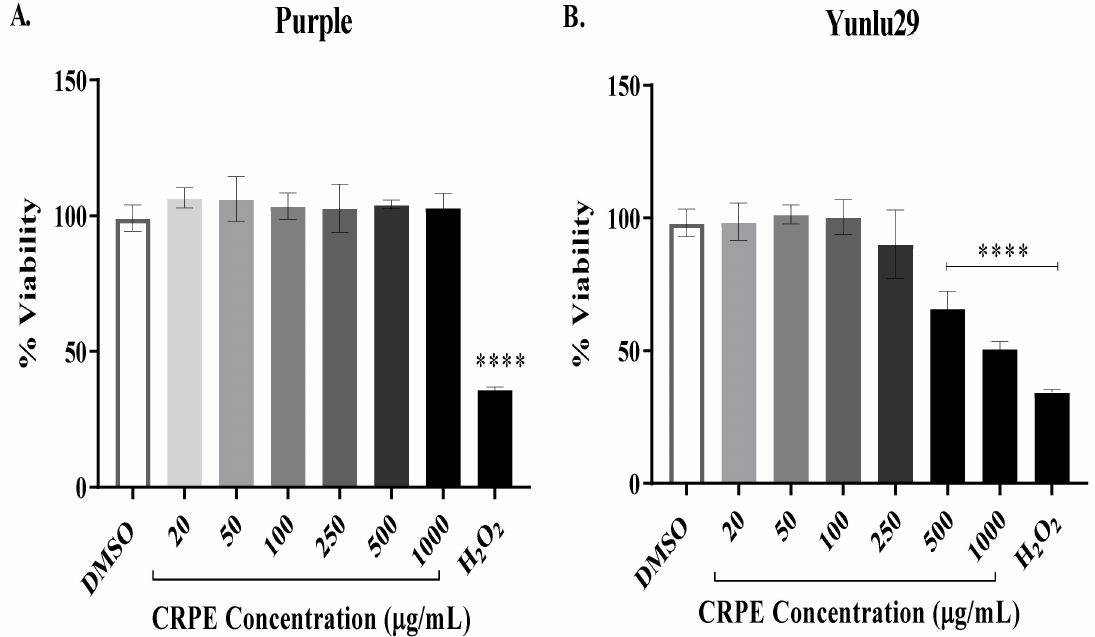
Figure 1. Cytotoxicity of coloured rice phenolic extracts (CRPE) on INS-1E cells. The cells were exposed to coloured rice extracts (purple [ A ] and Yunlu29 [ B ]) at various concentrations for 6 h, followed by resazurin red assay ( n = 5). Asterisks indicate significant di ff erences to the control group (DMSO), where, **** p < 0.0001; one-way ANOVA with turkey’s multiple comparison post hoc test. Data is presented as mean ± SEM. DMSO—dimethyl sulfoxide; H 2 O 2 —Hydrogen